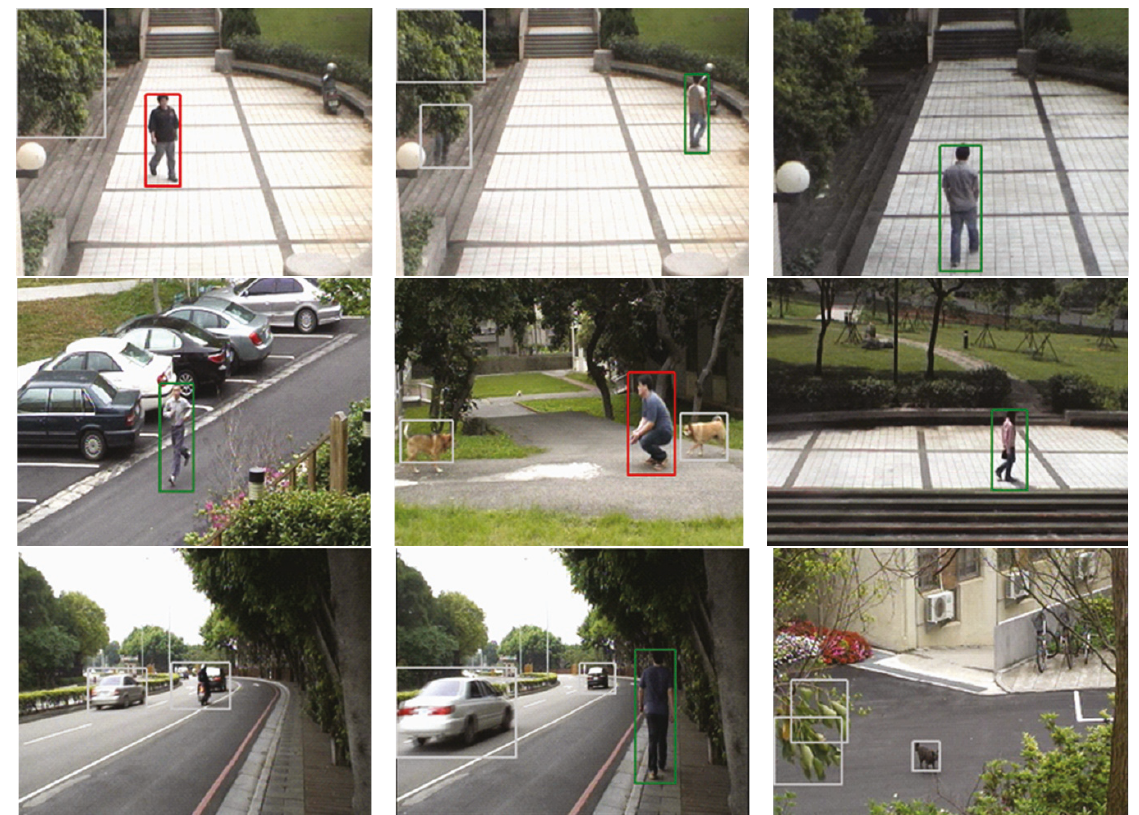
Figure 17: The detection results for humans and nonhumans.